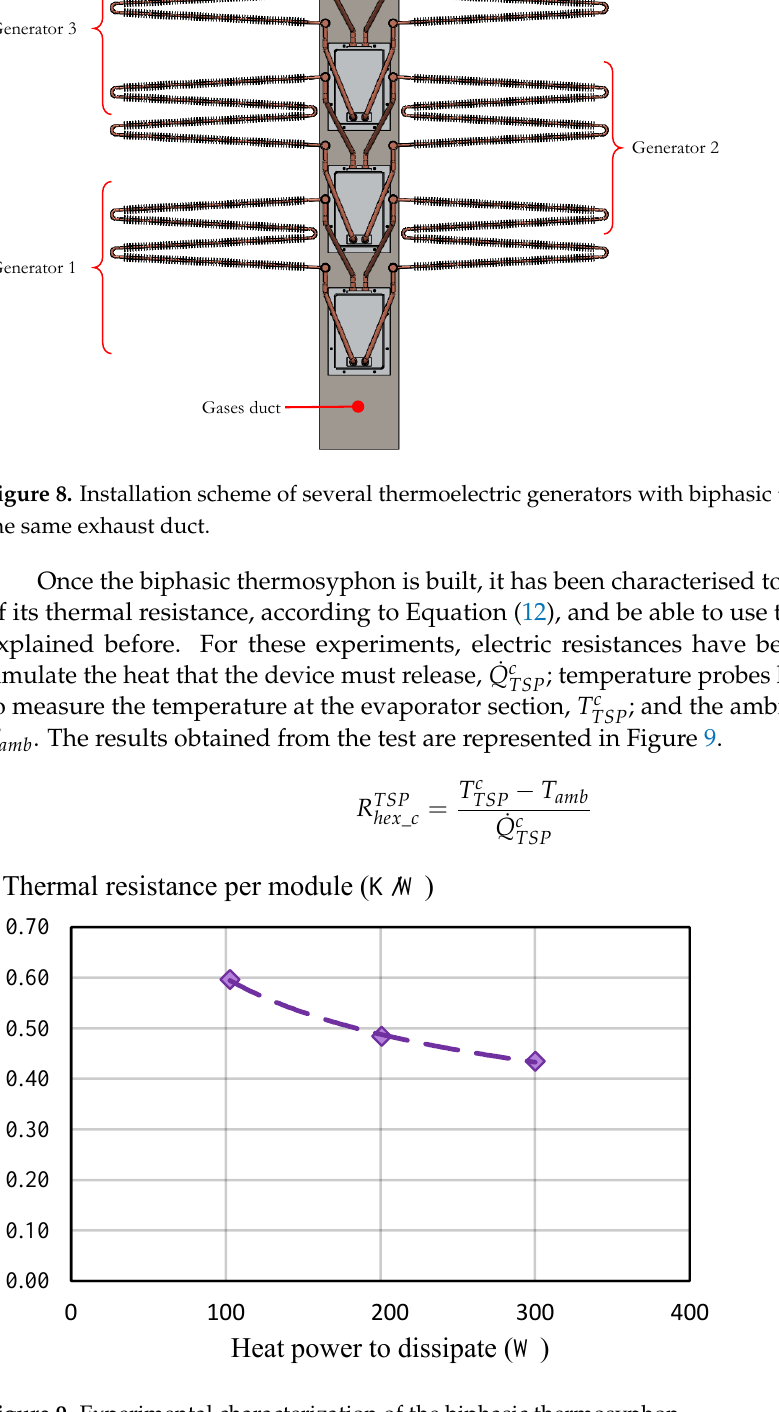
Figure 9. Experimental characterization of the biphasic